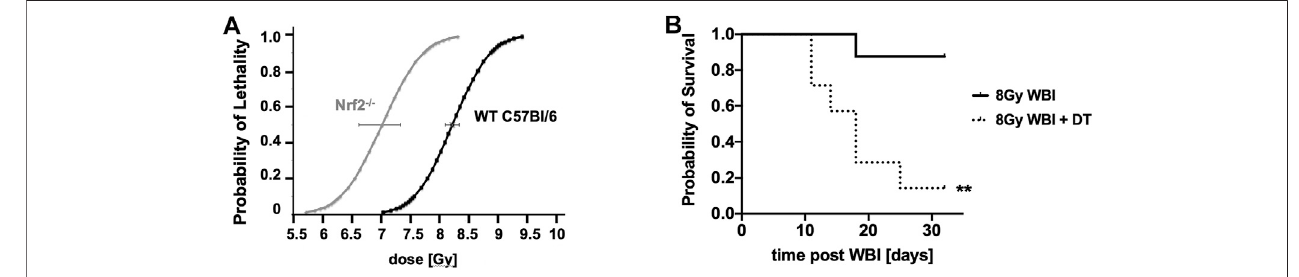
FIGURE9 | The impact ofNrf2 depletion (A) and Treg depletion in Diphtheria toxin(DT)-treated Foxp3DTR/EGFPtransgenic mice (B) (** p (cid:2) 0.0037) on responses to WBI compared to aged-matched controls. ** p < 0.01.